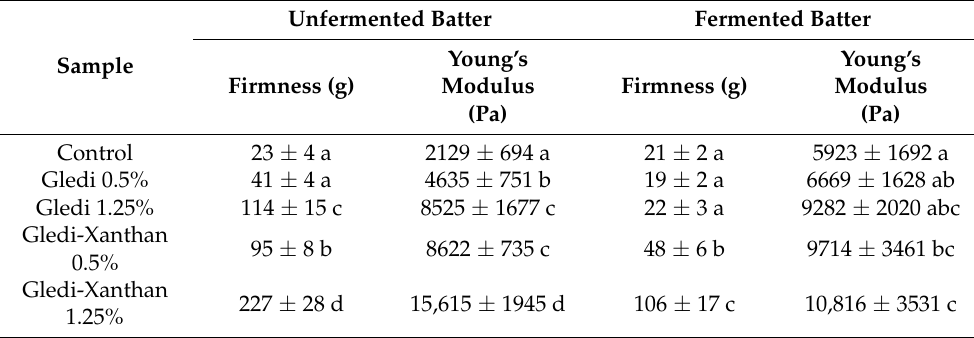
Table 3. Textural parameters of gluten-free